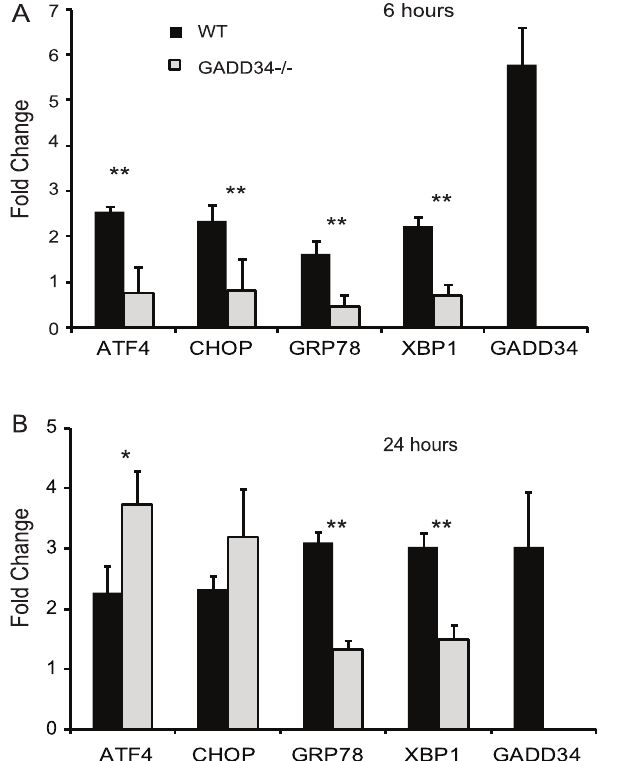
Figure 2. Deletion of GADD34 results in attenuation of the ERSR after SCI. Total RNA was extracted from injury epicenter of WT and GADD34 -/- mice at (A) 6 hours and (B) 24 hours-post SCI. Transcript level (normalized to GAPDH) is expressed as fold changes compared with levels in sham controls. Data (A,B) are the mean 6 SD (n=4, ** p , 0.01).